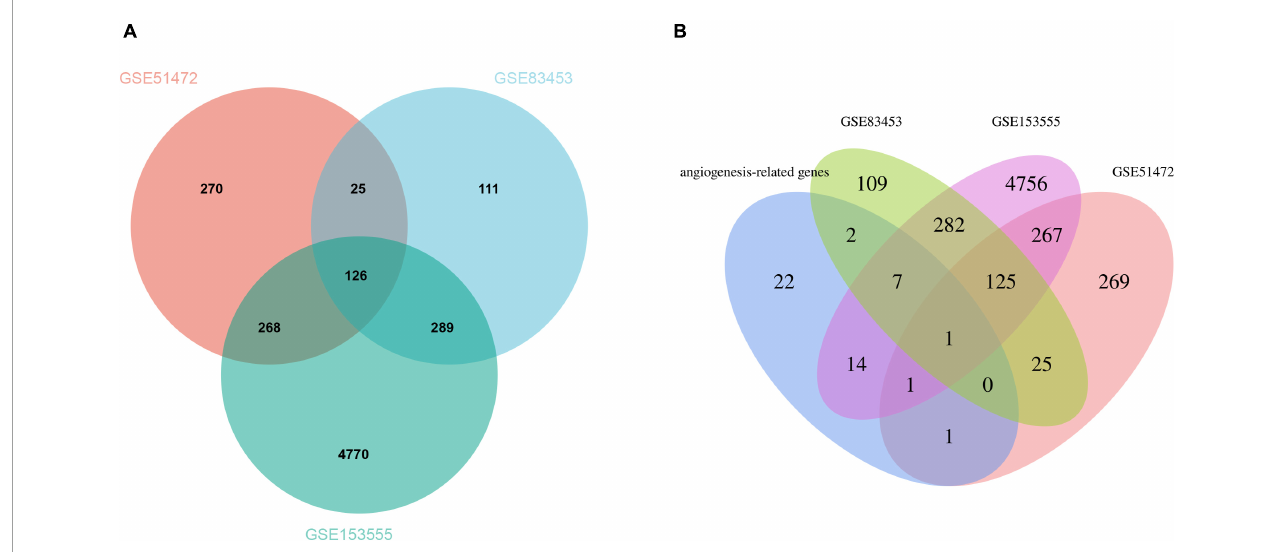
FIGURE2 (A) The Venn plot of DEGs from GSE83453, GSE51472, and GSE153555. (B) Venn plots showing the relationship between DEGs and angiogenesis-related genes across all three gene sets. Venn plots show the relationship between DEGs and angiogenesis-related genes in all three gene sets. Intersected DEGs and angiogenesis-related genes in at least two CAVD datasets were screened as strongly correlated genes, and one key gene was identified.